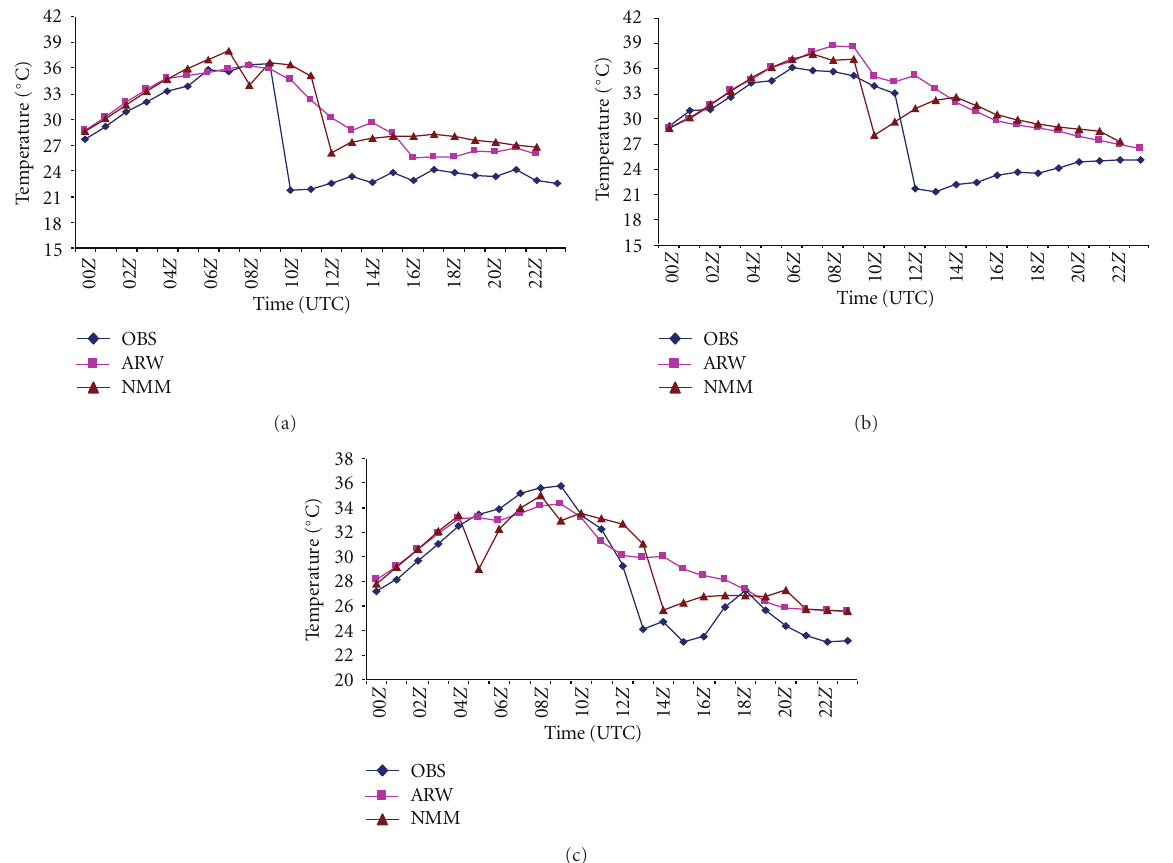
Figure 3: Inter, comparison of NMM- and ARW-model-simulated and observed diurnal variation of surface temperature ( ◦ C) over Kolkata on (a) 03, May, 2009 (b) 11, May, 2011 and (c) 15, May, 2011.